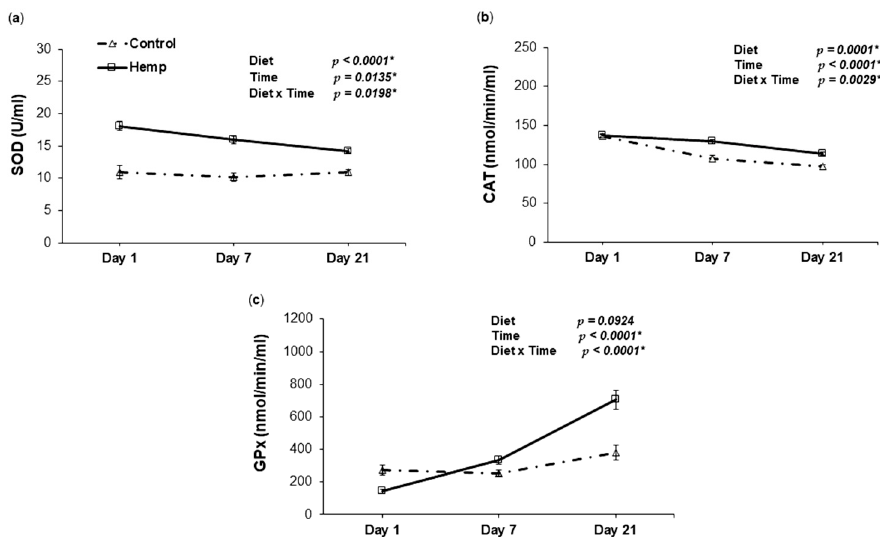
Figure 4. The e ff ect of HD on antioxidant enzymes activities in the plasma of piglets throughout the lactation period. ( a ) Relationship between SOD activity and day of lactation in the plasma of piglets fed a control ( ∆ symbol) or a hemp seed diet ( (cid:3) symbol); ( b ) Relationship between CAT activity and day of lactation in the plasma of piglets fed a control ( ∆ symbol) or a hemp seed diet ( (cid:3) symbol); ( c ) Relationship between GPx activity and day of lactation in the plasma of piglets fed a control ( ∆ symbol) or a hemp seed diet ( (cid:3) symbol). The p -values for the e ff ects of treatment (diet), time and diet–time interaction are shown. Data are means ± SEM ( n = 8). Asterisk (*) indicates significance ( p < 0.05*).